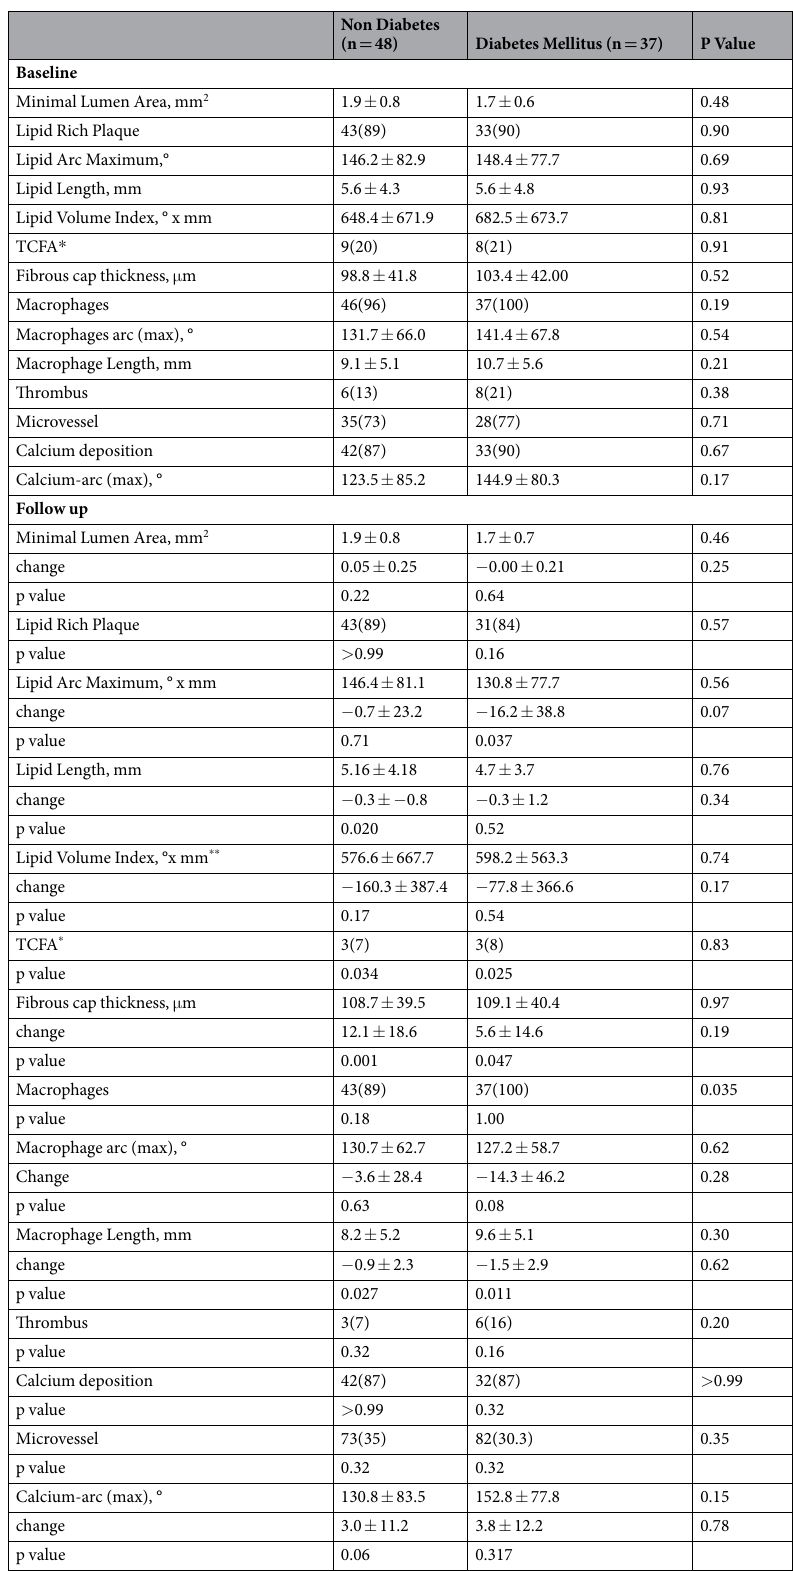
Table 3. Optical Coherence Tomography findings at baseline and follow up Values are mean ± SD or n